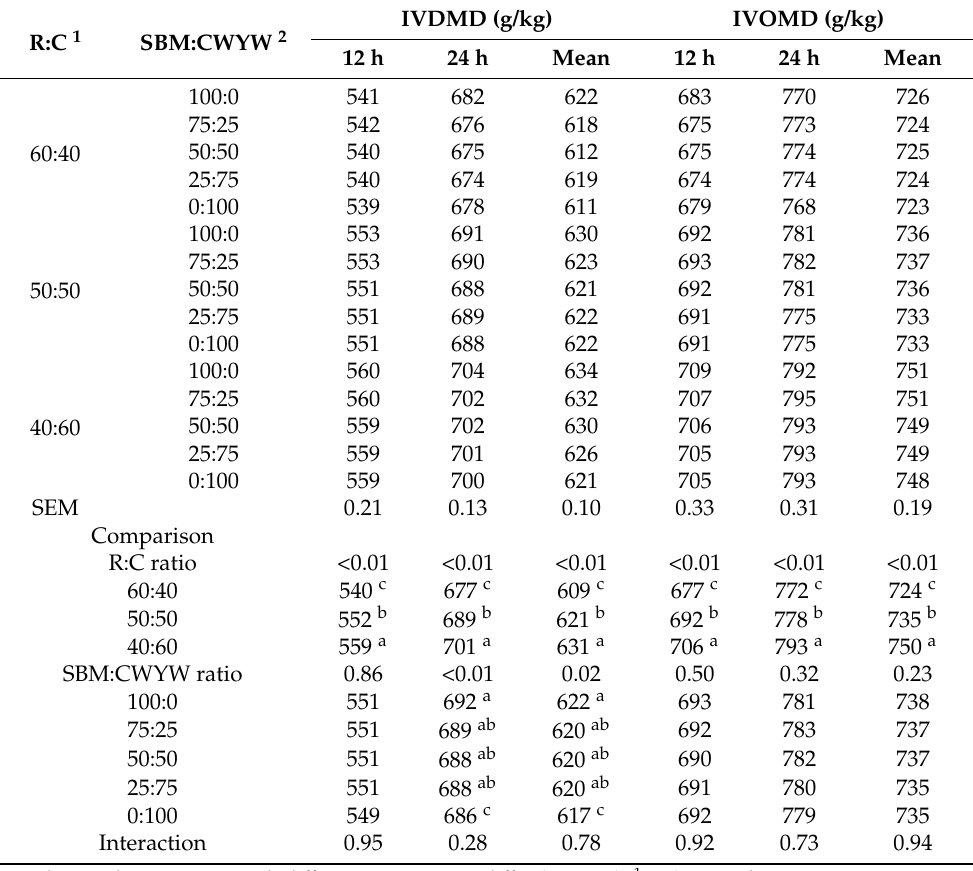
Table 3. Effect of R:C ratio level combined with SBM:CWYW ratio level on in vitro dry matter digestibility (IVDMD) and in vitro organic matter digestibility